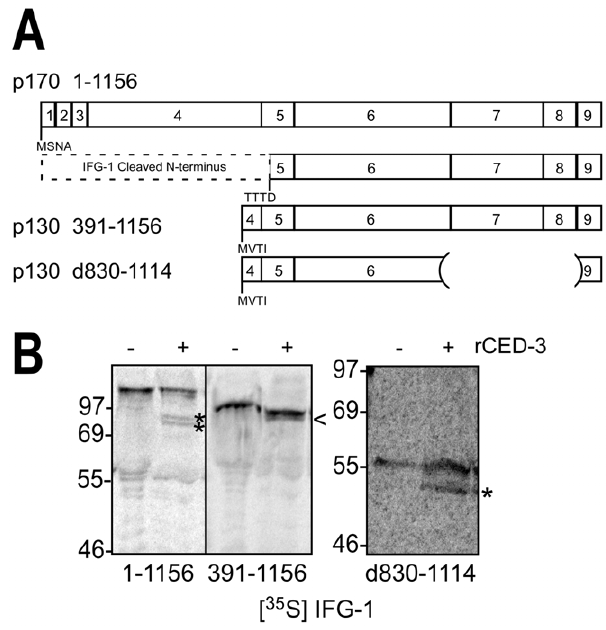
Figure 7. CED-3 cleaves IFG-1 p130 invitro . (A) Schematic diagram depicting the mapped CED-3 cleavage site and translation starts in full length IFG-1 p170 (1–1156), p130 (391–1156) and an internally truncated version of p130 (d830–1114). Numbered boxes correspond to protein encoding exons. (B) Radiolabeled IFG 1–1156, 391–1156 and d830–1114 proteins were incubated with rCED-3 ( + ) as